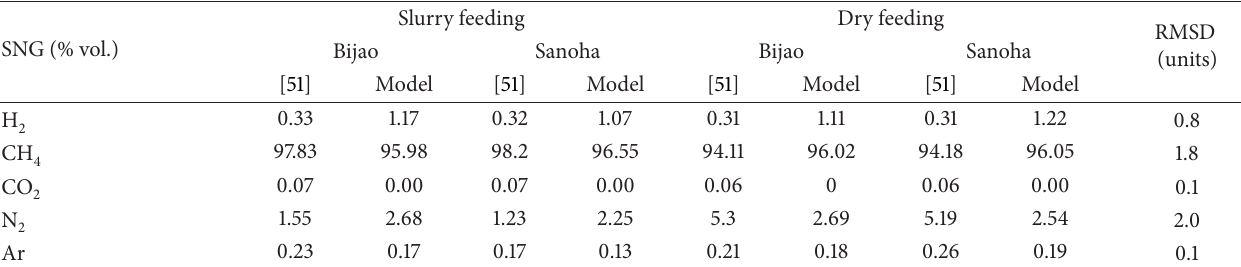
Calculated as the average of the four pairs simulation-reported data described in each entire row. Table 6: Comparison between SNG compositions simulated and reported data under slurry and dry feeding technologies. SNG (%